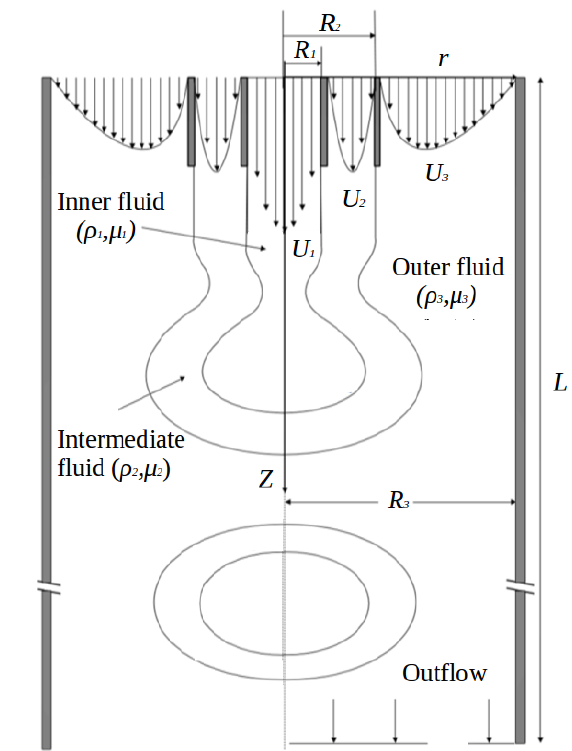
Figure 1. Schematic of breakup of a compound jet, and a resulting compound